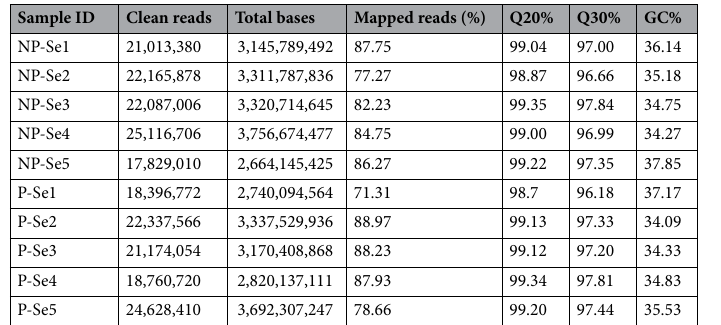
Table 3. The RNA-Seq data for 10 samples. Q20% means the sequencing error rate of the base was less than 1%; Q30% means the sequencing error rate of the base was less than 0.1%.